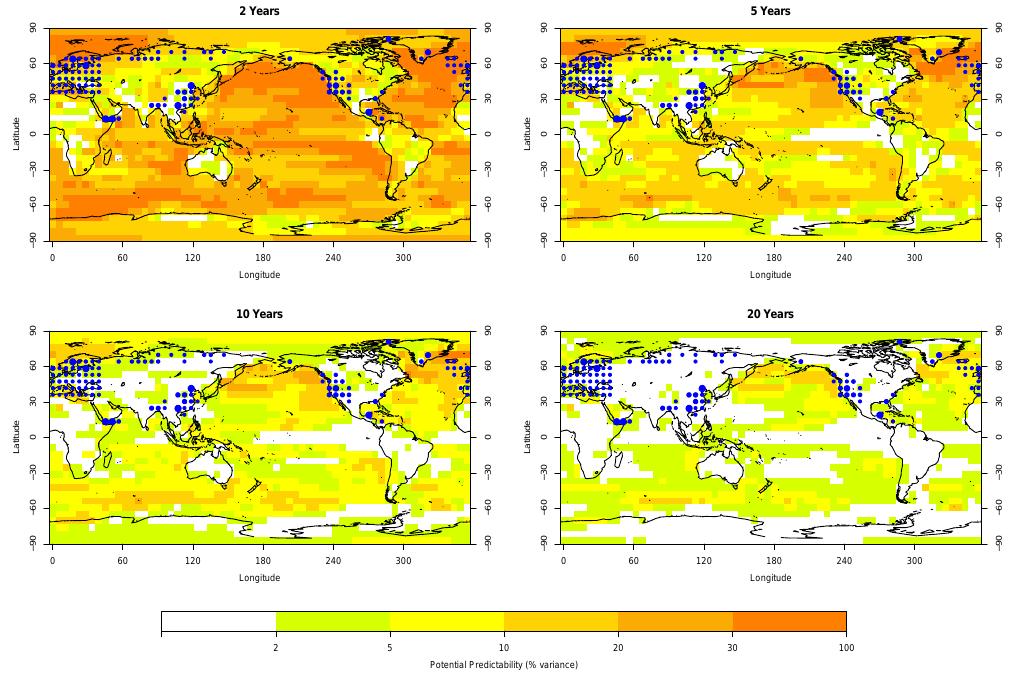
Fig. 1. Potential predictability. σ 2 v /σ 2 for different time scales, where σ 2 v is the variance of the long time scale and σ 2 is the total variance. Also indicated are data locations (blue dots) with the size of the dot proportional to the length of time series available, which ranges between 500yr (smallest 65 dots) and 2000yr (largest 6